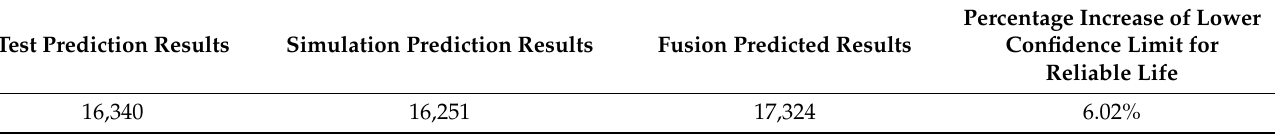
Table 6. Reliable life prediction results obtained by fusing current test data with simulation data (Unit: